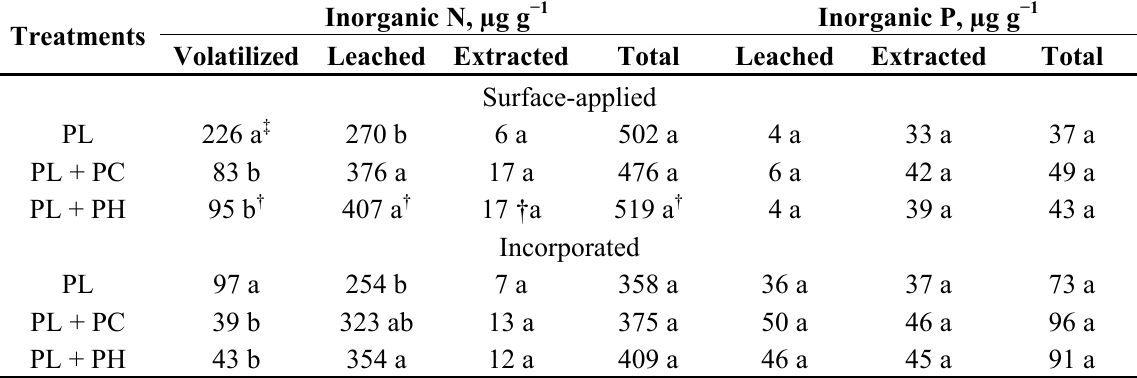
Table 2. Total Inorganic N and P released from surface-applied or incorporated poultry litter with or without acidified biochars (control treatment subtracted).